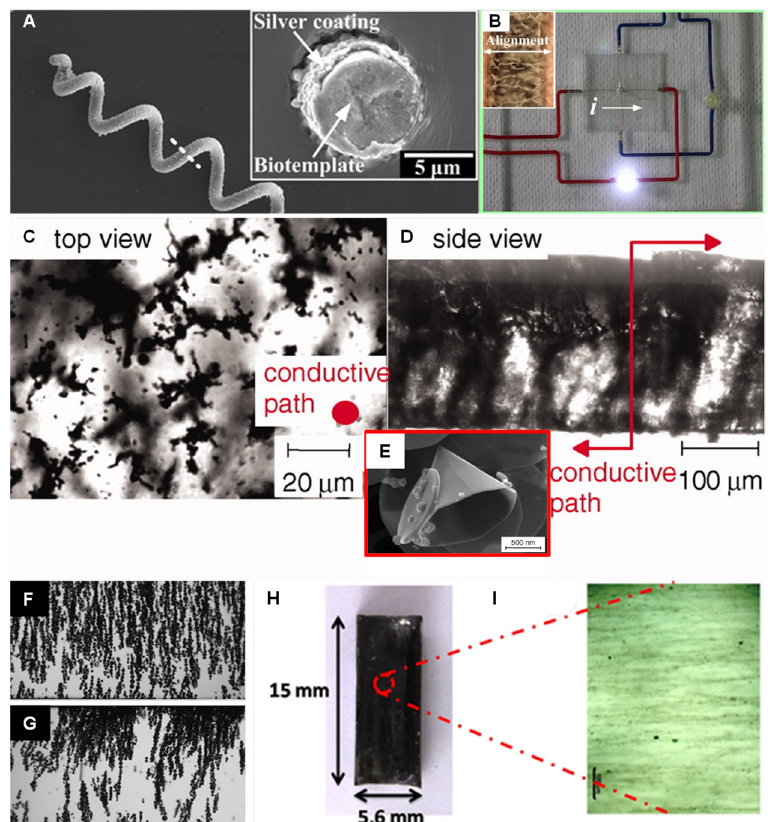
Figure 2. ( A ) SEM image of a metallic Spirulina-templated microcoil. The inset shows a cross-section of the microcoil particle; ( B ) the application of a 5 wt% electric field-aligned microcoil/PDMS composite in a functional LED integrated circuit. Reprinted with permission from [79], copyright 2017 American Chemical Society; optical micrographs showing ( C ) the top view and ( D ) side view of a thermally cured carbon nanocone film (0.2 vol %), which was assembled by DC field alignment; ( E ) inset shows an SEM image of the nanocone used in this process. Reprinted with permission from [80], copyright 2011 John Wiley and Sons; ( F ) hollow glass microspheres dispersed in Norland optical adhesive initially chain before ( G ) migrating towards an electrode. Reprinted with permission from [81], copyright 2017 Elsevier; ( H ) an acrylate polymer composite consisting of ( I ) SWCNT aligned using an AC electric field. Reprinted with permission from [82], copyright 2014 John Wiley and Sons.